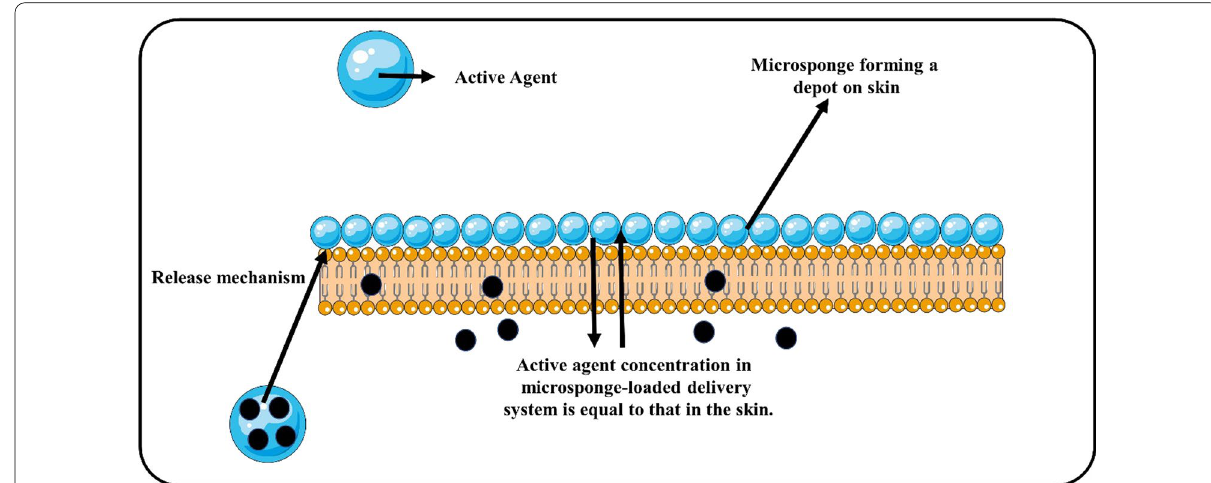
Fig. 16 Microsponge drug mechanism in skin infections